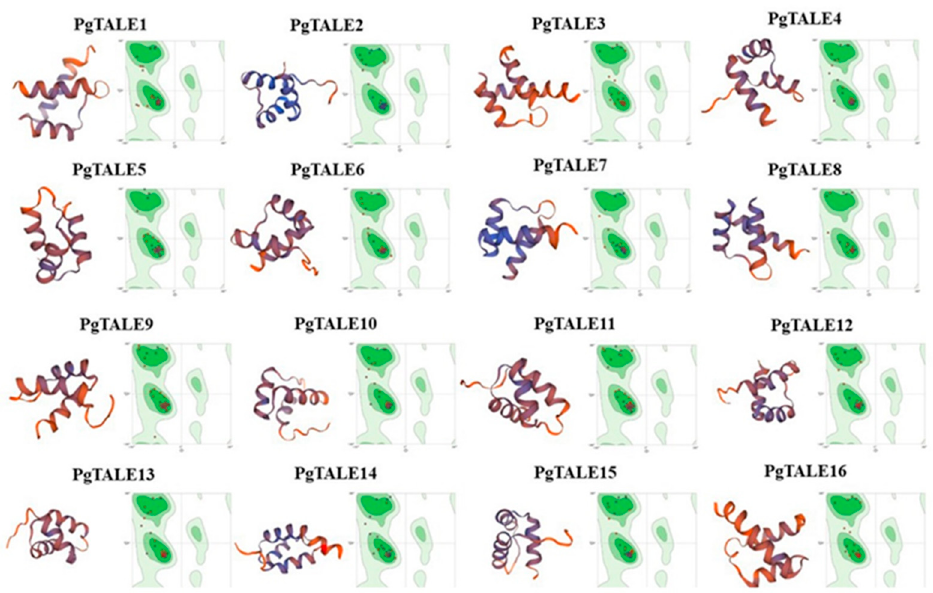
Figure 3. Tertiary structure and Ramachandran plot of PgTALE protein. The tertiary structure of the protein was analyzed through the online SWISS-MODEL.